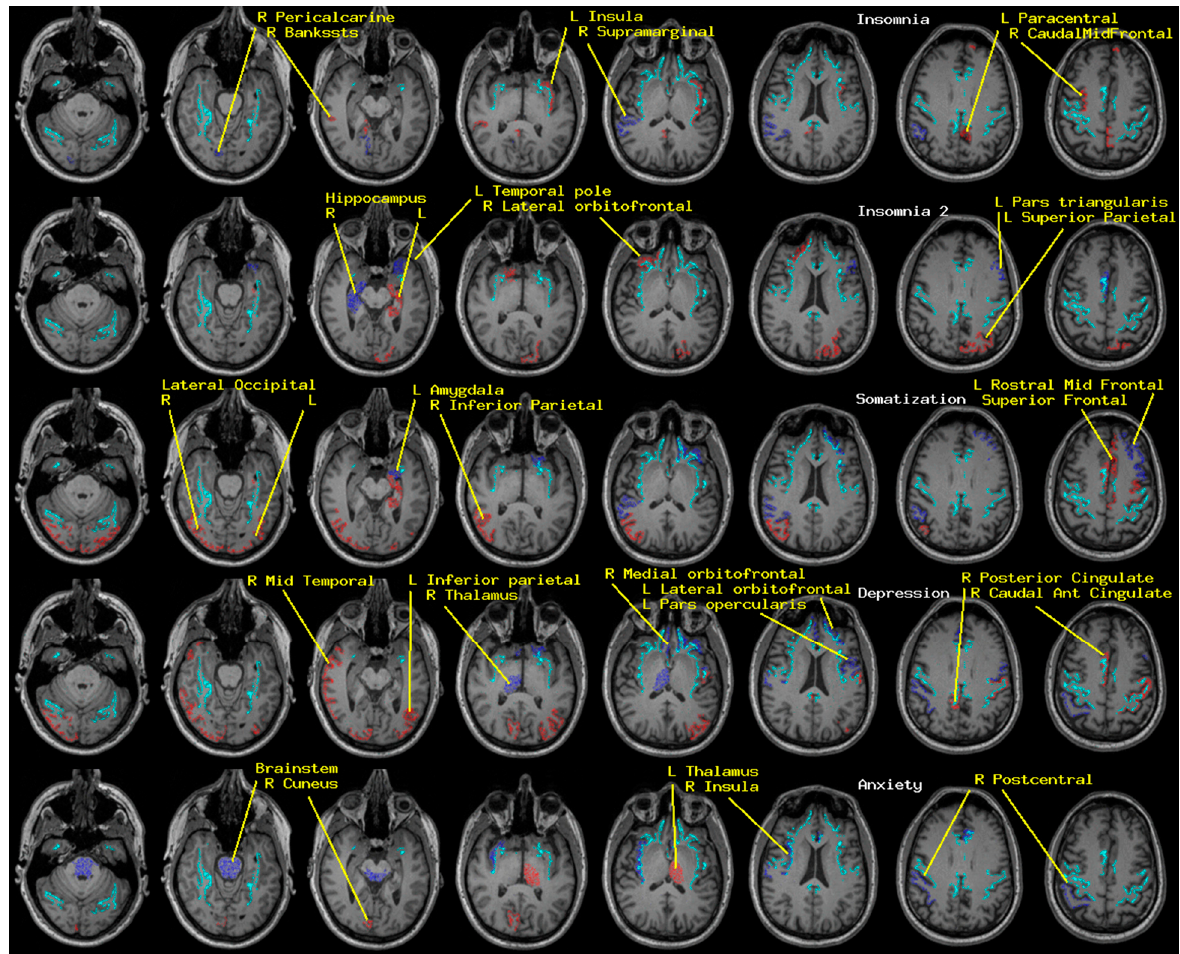
Figure 1. The regions whose neuroelectric activity values contributed to the symptom-specific classifiers reported in Tables 1 and 2 are shown. Each row shows the regions for the indicated symptom. From top to bottom, they are insomnia, insomnia (2nd step), somatization, depression, and anxiety. The MR imaging (MRI) slices range from left to right, inferior to superior in one-centimeter increments. The left side of each slice is the right brain. Activity in blue/red regions was higher/lower in those who screened positive. The cyan landmarks are the boundaries between gray and white matter in the precentral, cingulate, insula, and fusiform